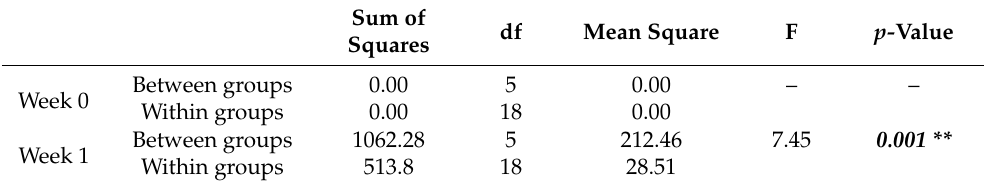
Table 5. BBB score comparison using one-way ANOVA with group factor ( n =